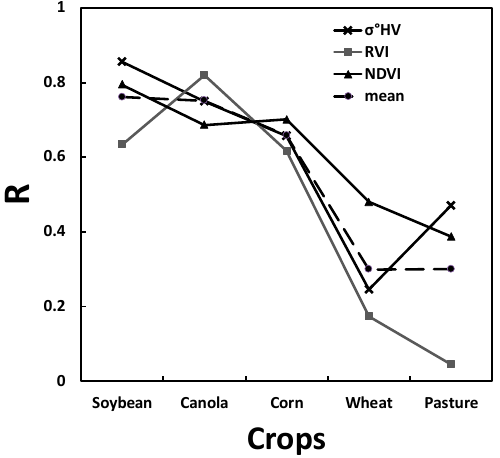
Figure 5. The plots of R values between LAI and vegetation descriptors for crop types calculated from Figure 4.